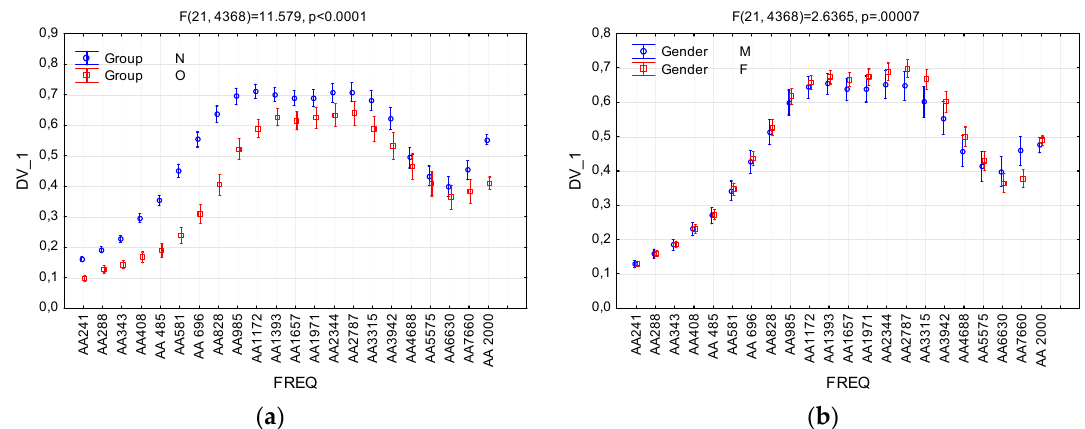
Figure 6. Effects of interactions between the variables Group ( a ), Gender ( b ), and absorbance, and the dependent variable DV_1. FREQ levels AA241, …, AA7660 denote average absorbance in consecutive quarter-octave frequency bands; AA2000 denotes average absorbance in the 226 – 2000 Hz band. Whiskers denote 95% confidence intervals. N — Normal group; O — Otosclerotic group; M — Male; and F — Female.